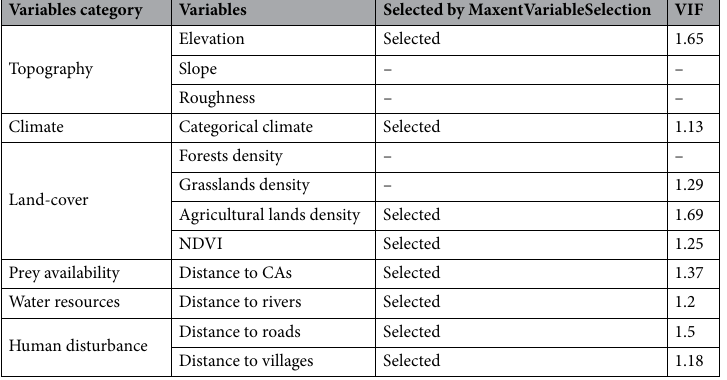
Table 1. Environmental variables using for habitat modeling of the striped hyaena in the study